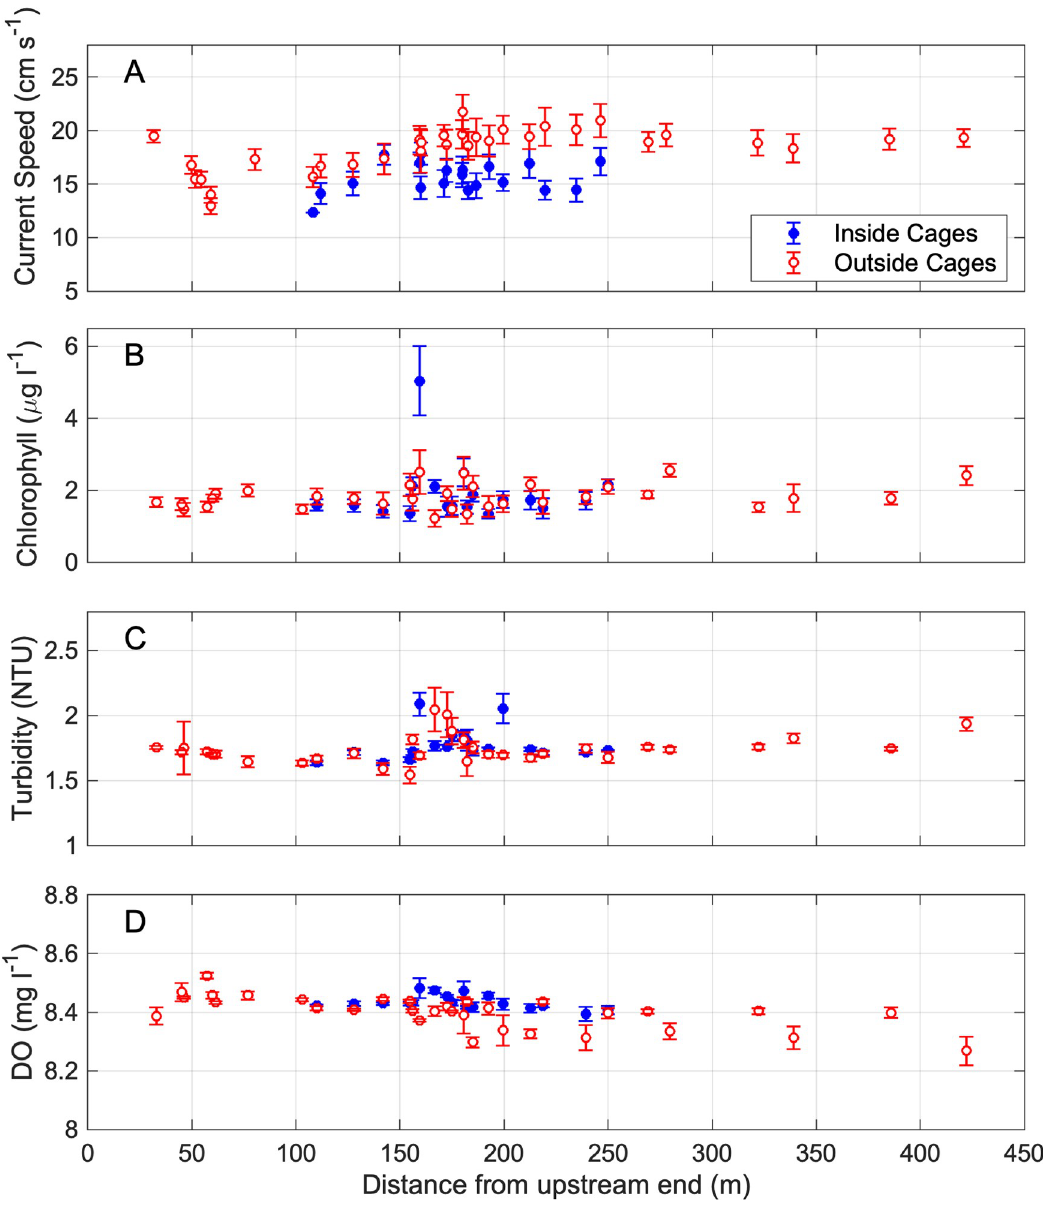
Fig 8. Current speed and water quality inside and outside cages by transect along distance from upstream end of sampling at Windmill Point. Data were collected at Windmill Point in summer 2017, including (A) current speed, (B) chlorophyll, (C) turbidity, and (D) DO. Open red circles indicate means of points outside the extent of cages on each transect, and filled blue circles indicate means of points inside the extent of cages on those transects that included both inside and outside points. Error bars represent ± one standard